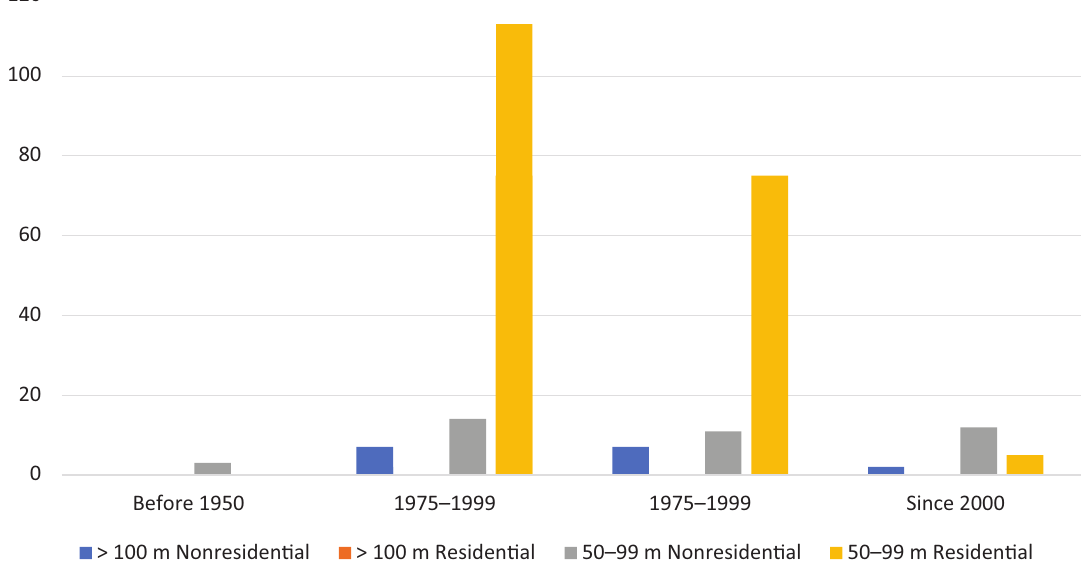
Figure 1. Construction of tall buildings (50 m and above) in Berlin. Sources: Author’s work based on personal observations, Hilgenstock (2011), Wikipedia (2022a), and Zabel